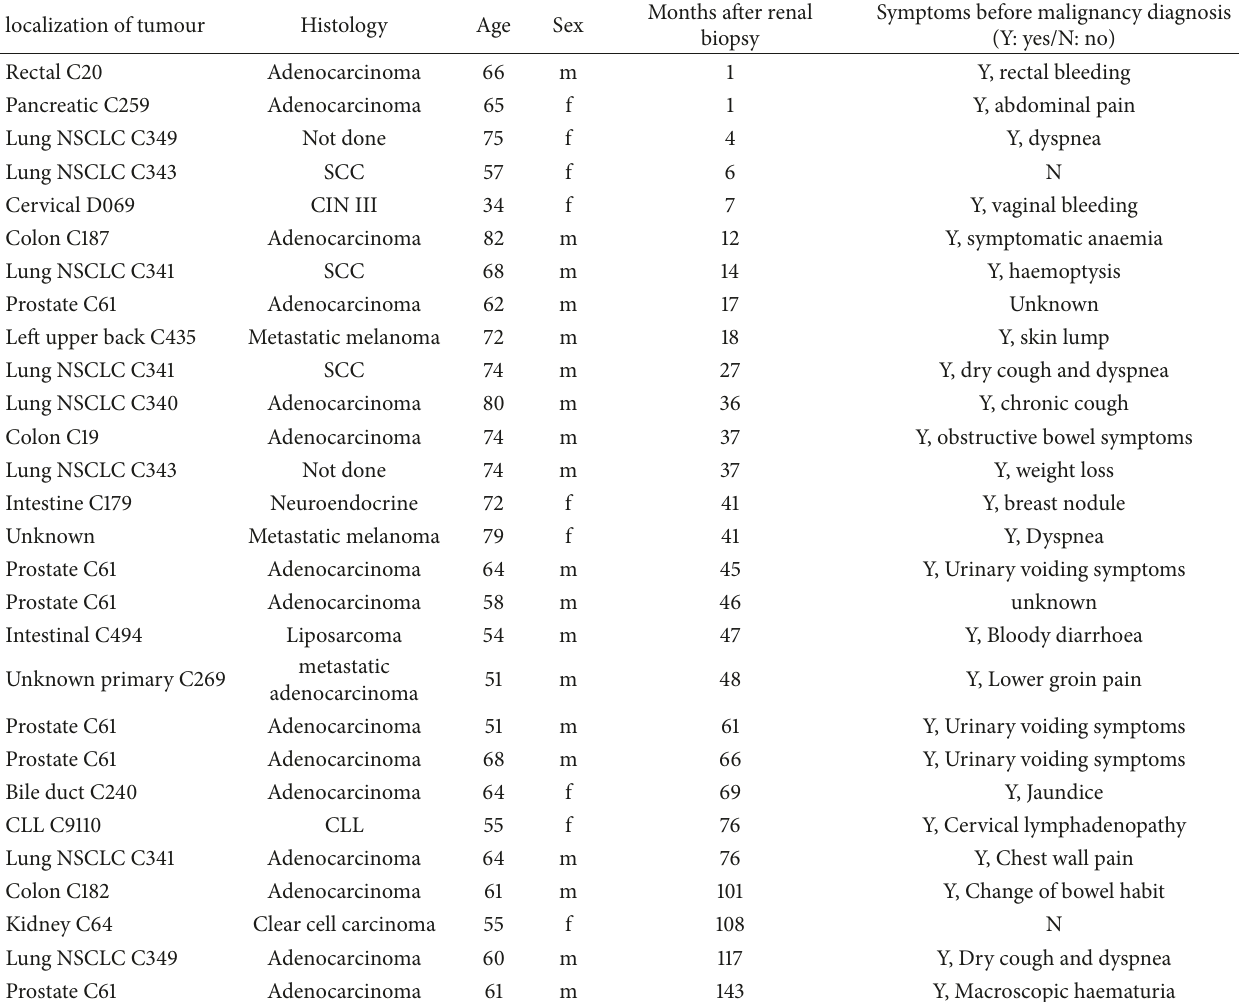
Table 3: Types of malignancy and symptoms in new malignancies after